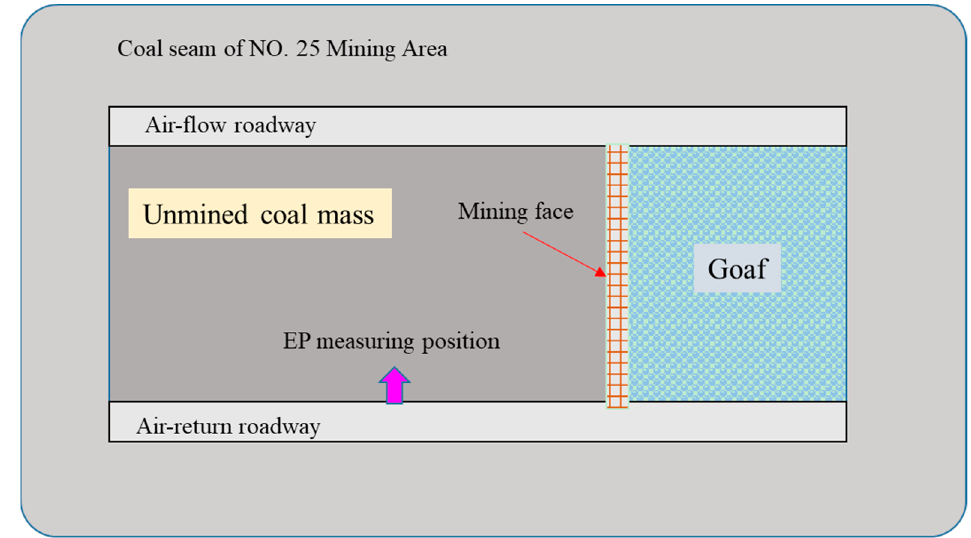
Figure 11. Schematic diagram of EP measuring layout in the coal seam of the NO. 25 Mining Area.